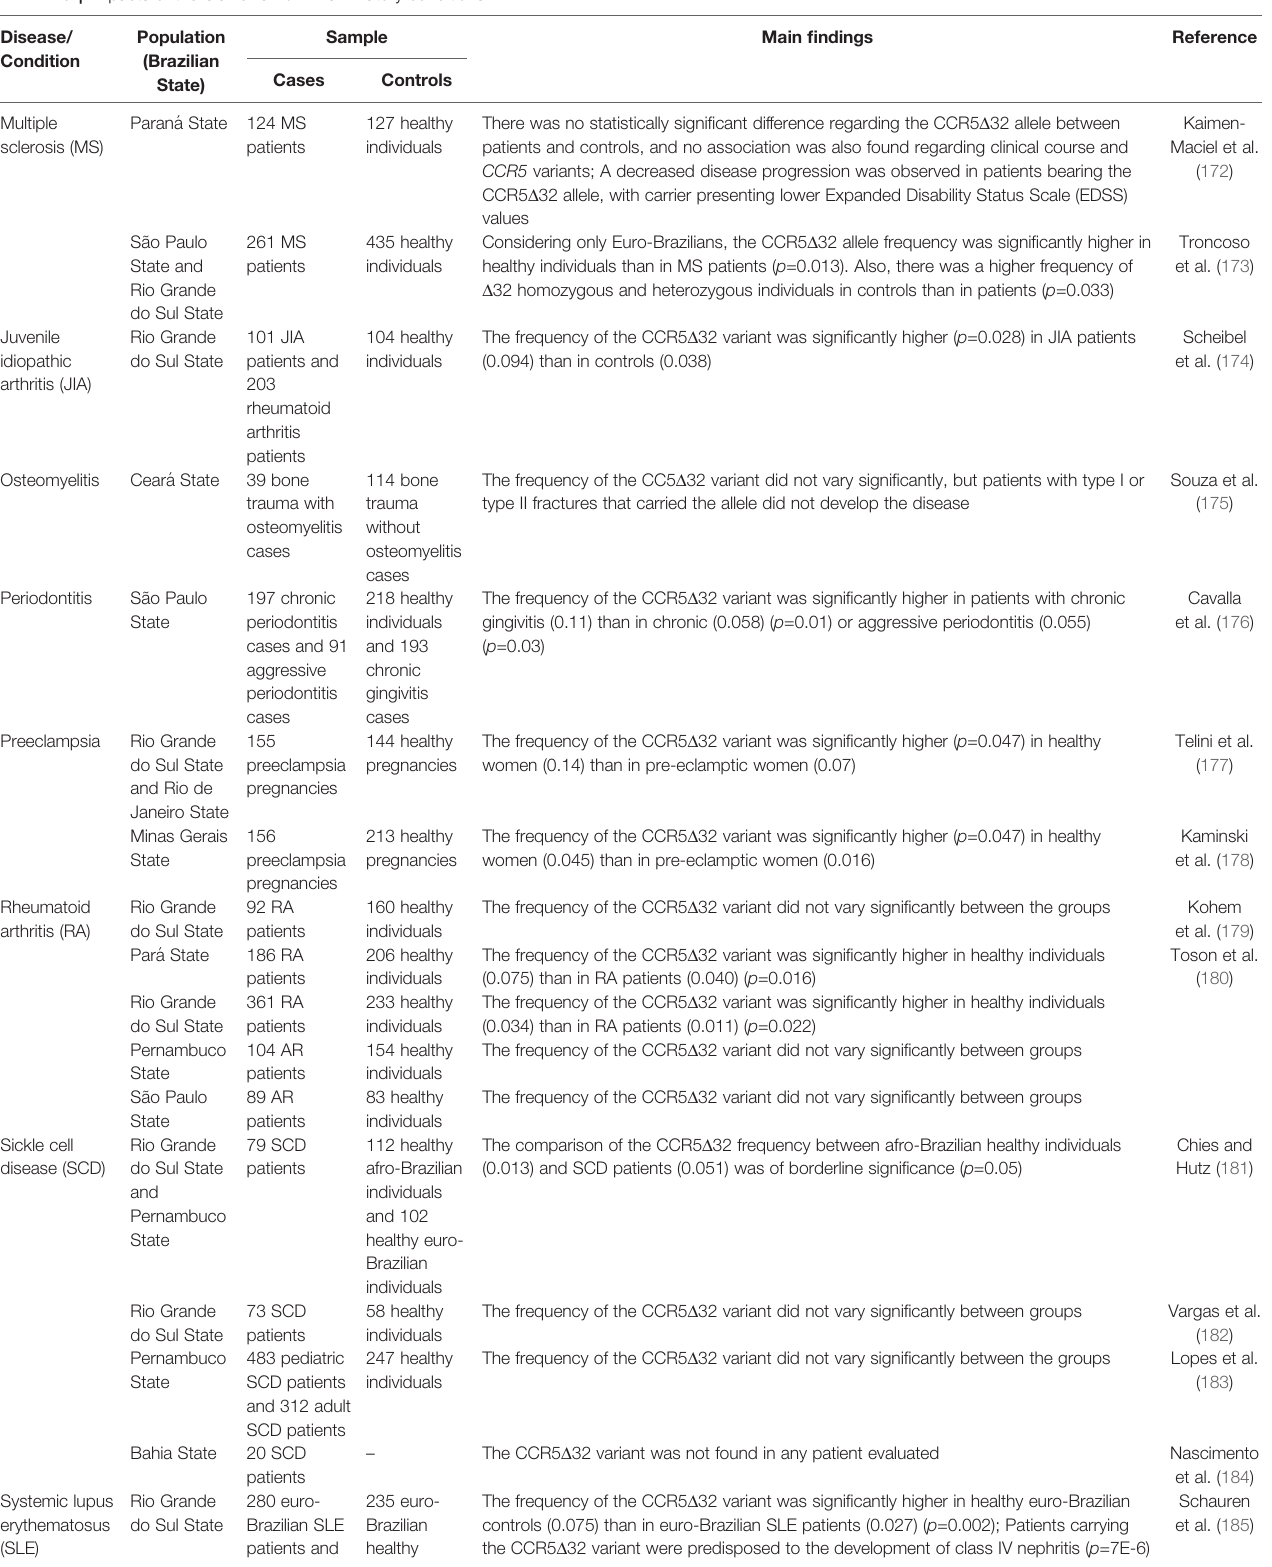
TABLE 3 | Impacts of the CCR5 D 32 on in fl ammatory conditions. Disease/